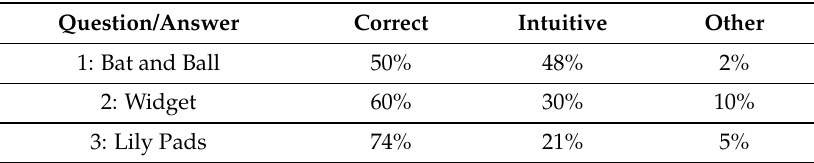
Table A9. Distribution of Answers on the CRT for Women Alone.